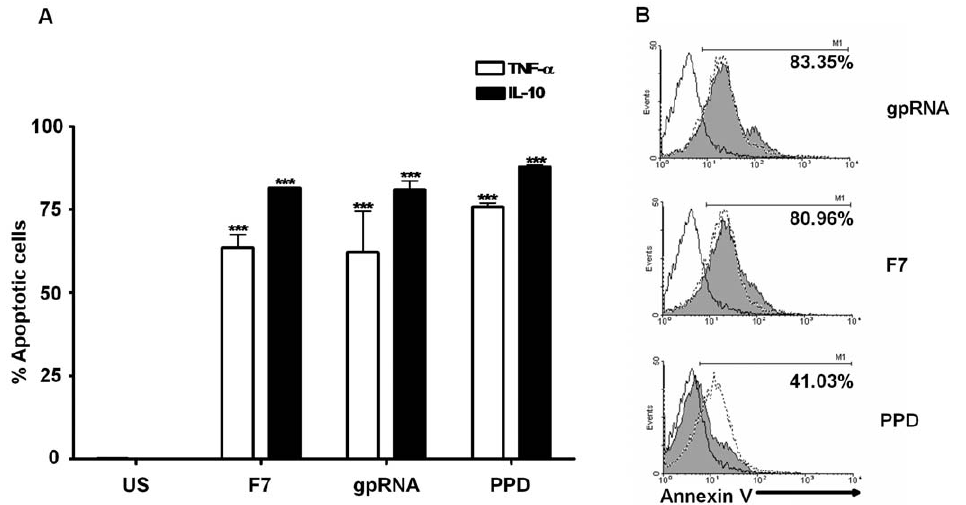
Figure 4. Human monocyte apoptosis induced by extracellular M.tuberculosis H37Rv RNA is TNF- a independent. A. TNF- a (open bars) and IL-10 (closed bars) induced in human monocytes treated with DEAE-Sepharose Fractions 7 (F7), gel purified M. tuberculosis H37Rv (gpRNA) and purified protein derivative (PPD) from M. tuberculosis were measured by flow cytometry and the data presented as the percentage of human monocytes producing the cytokine, *** significance p , 0.001 as compared to unstimulated control. B. Human monocytes were incubated with gpRNA, F7 or PPD, and annexinV staining was measured by flow cytometry (open histogram with dotted line) to assess apoptosis. Treatment of monocytes with anti-TNF- a for 1 h prior to stimulation with F7, gpRNA, or PPD demonstrated no alteration in annexinV staining for monocytes incubated with F7 or gpRNA, but did result in decreased annexinV staining for monocytes incubated with PPD (closed histogram). The open histograms with a solid line correspond to unstimulated